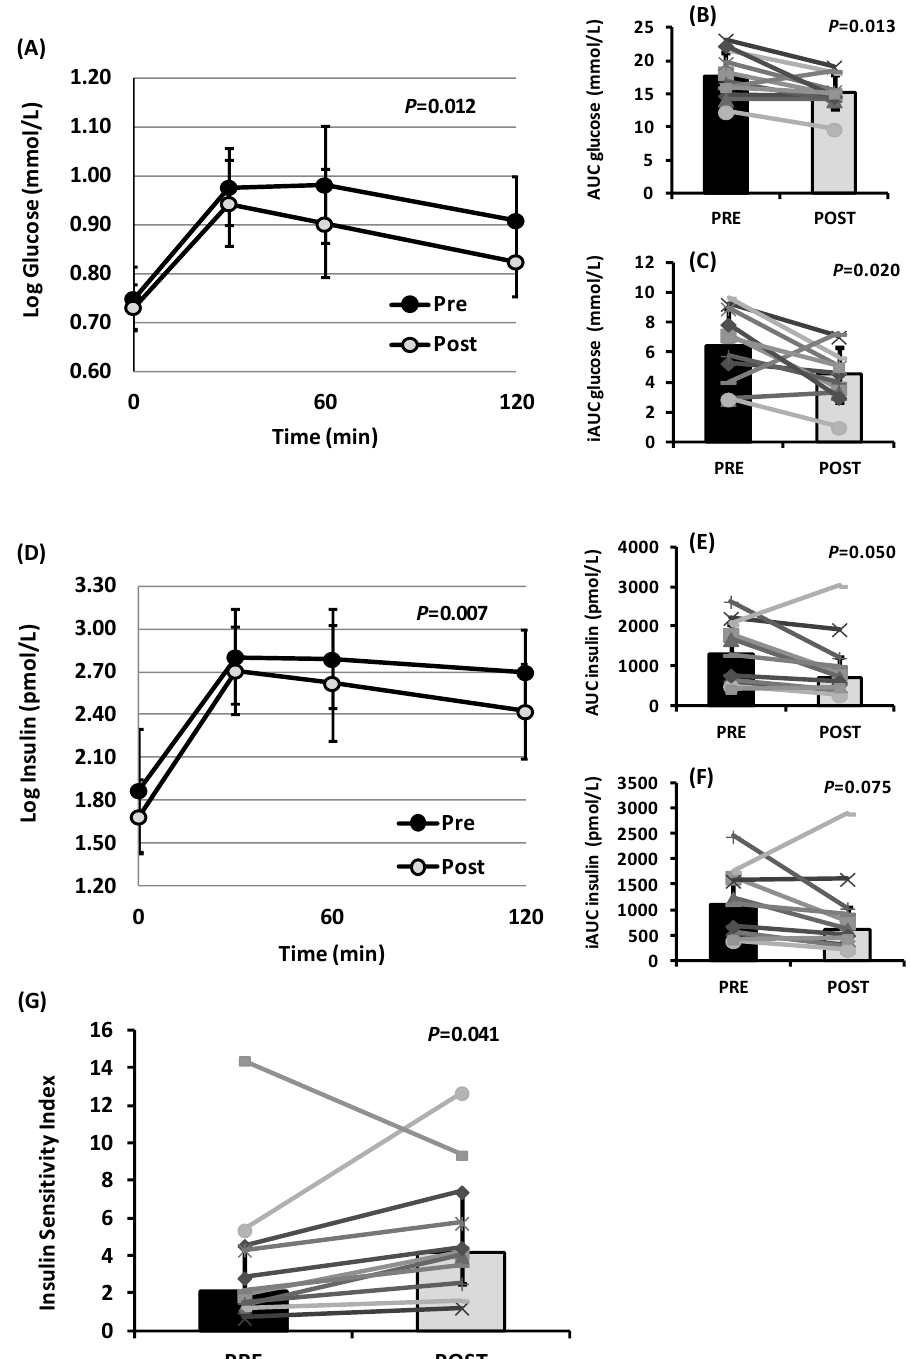
Figure 3. Oral glucose tolerance test (OGTT) in overweight and obese participants before (pre) and after (post) the dietary intervention with the modified Mediterranean diet (n = 11). ( A ) Postprandial plasma glucose. ( B ) Total areas under the curves (AUCs) for glucose. ( C ) Incremental areas under the concentration-versus-time curves (above fasting values, iAUCs) for glucose. ( D ) Postprandial serum insulin. ( E ) AUCs for insulin. ( F ) iAUCs for insulin. ( G ) Postprandial ISI. p -values were derived from paired t -tests or Wilcoxon rank tests or ANOVA for repeated measures. Statistical significance was set at the 5% level. ANOVA, analysis of variance; ISI, insulin sensitivity index.